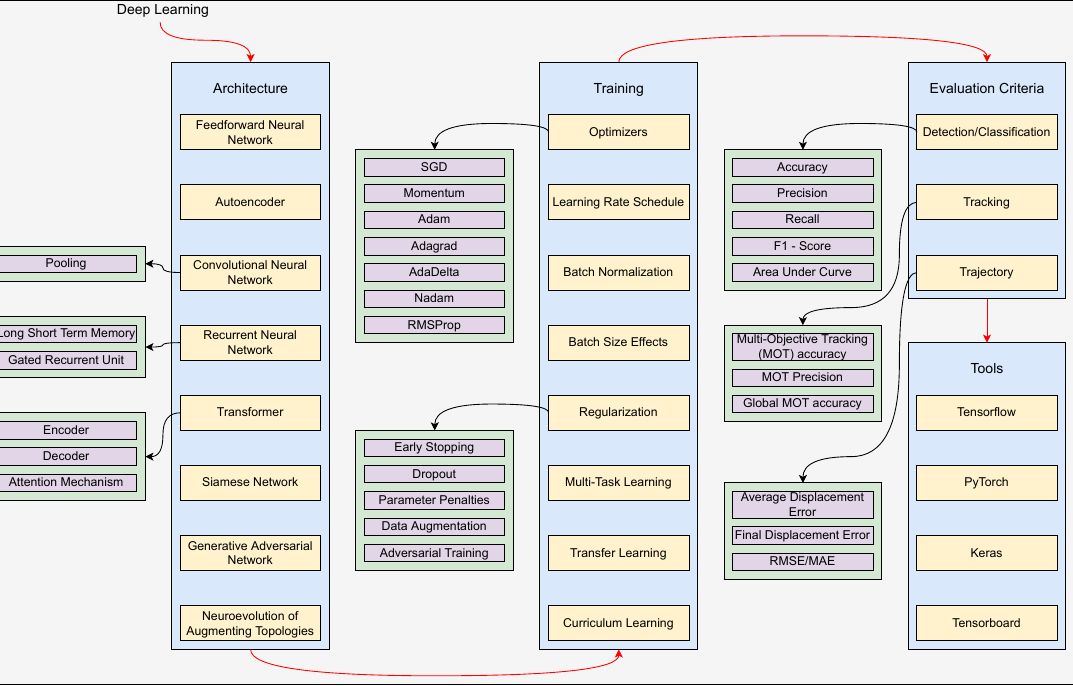
Figure 9. Block diagram of the road map to deep learning architecture selection and